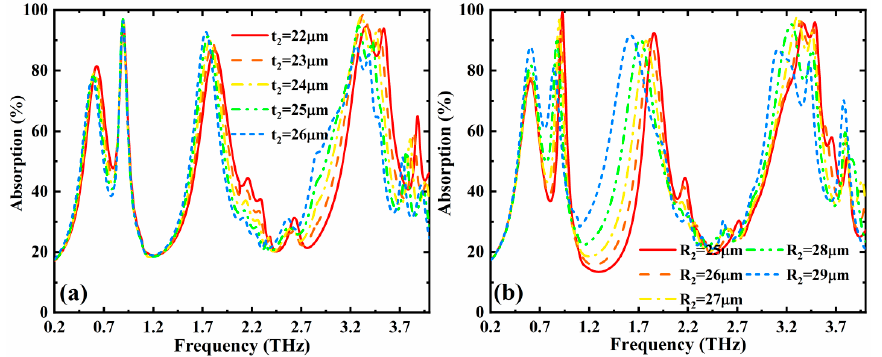
Figure 6. Absorption versus operation frequency with different ( a ) R 2 and ( b ) t 2 when the conductivity of VO 2 and chemical potential of graphene are σ VO